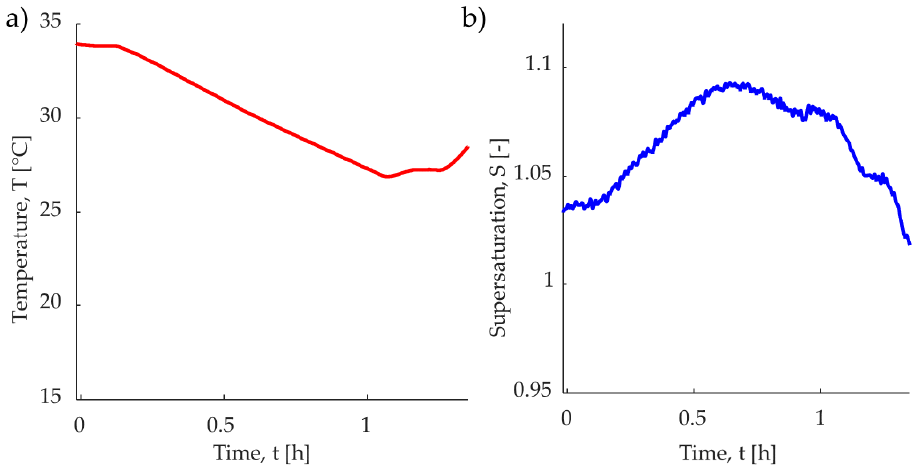
Figure A3. ( a ) Temperature profile of the Exp. 1—KH 2 PO 4 : saturation, seeding, linear cooling ramp, and final temperature. ( b ) Concentration profile of Exp. 3—KH 2 PO 4 : FTIR, o ffl ine samples and saturation curve.